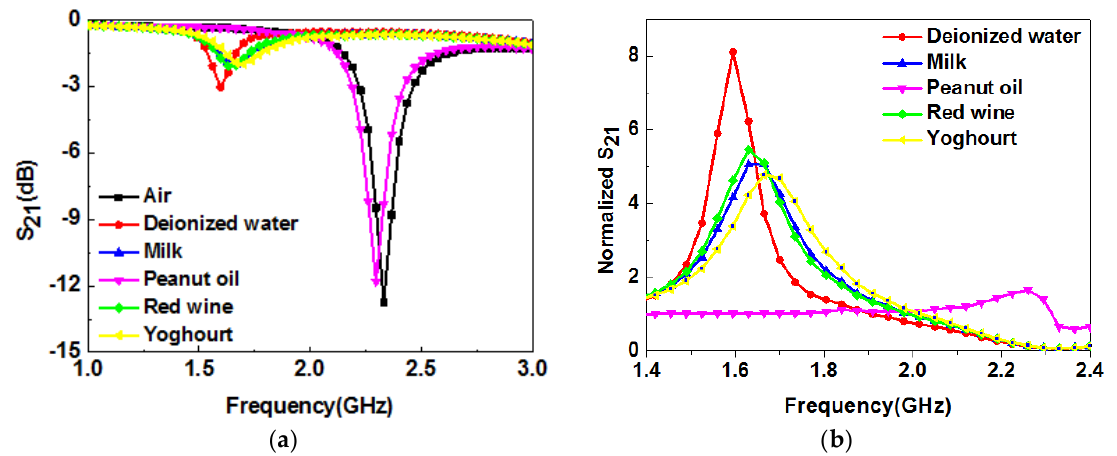
Figure 9. ( a ) Measured resonance characteristics of different liquids; ( b ) Measured resonance characteristics in (a) divided by the reference signal.